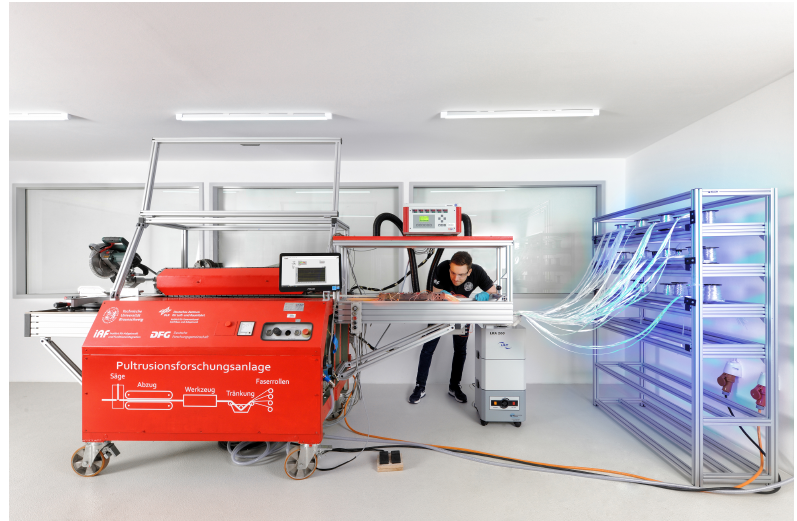
Figure 1. Small experimental pultrusion system.